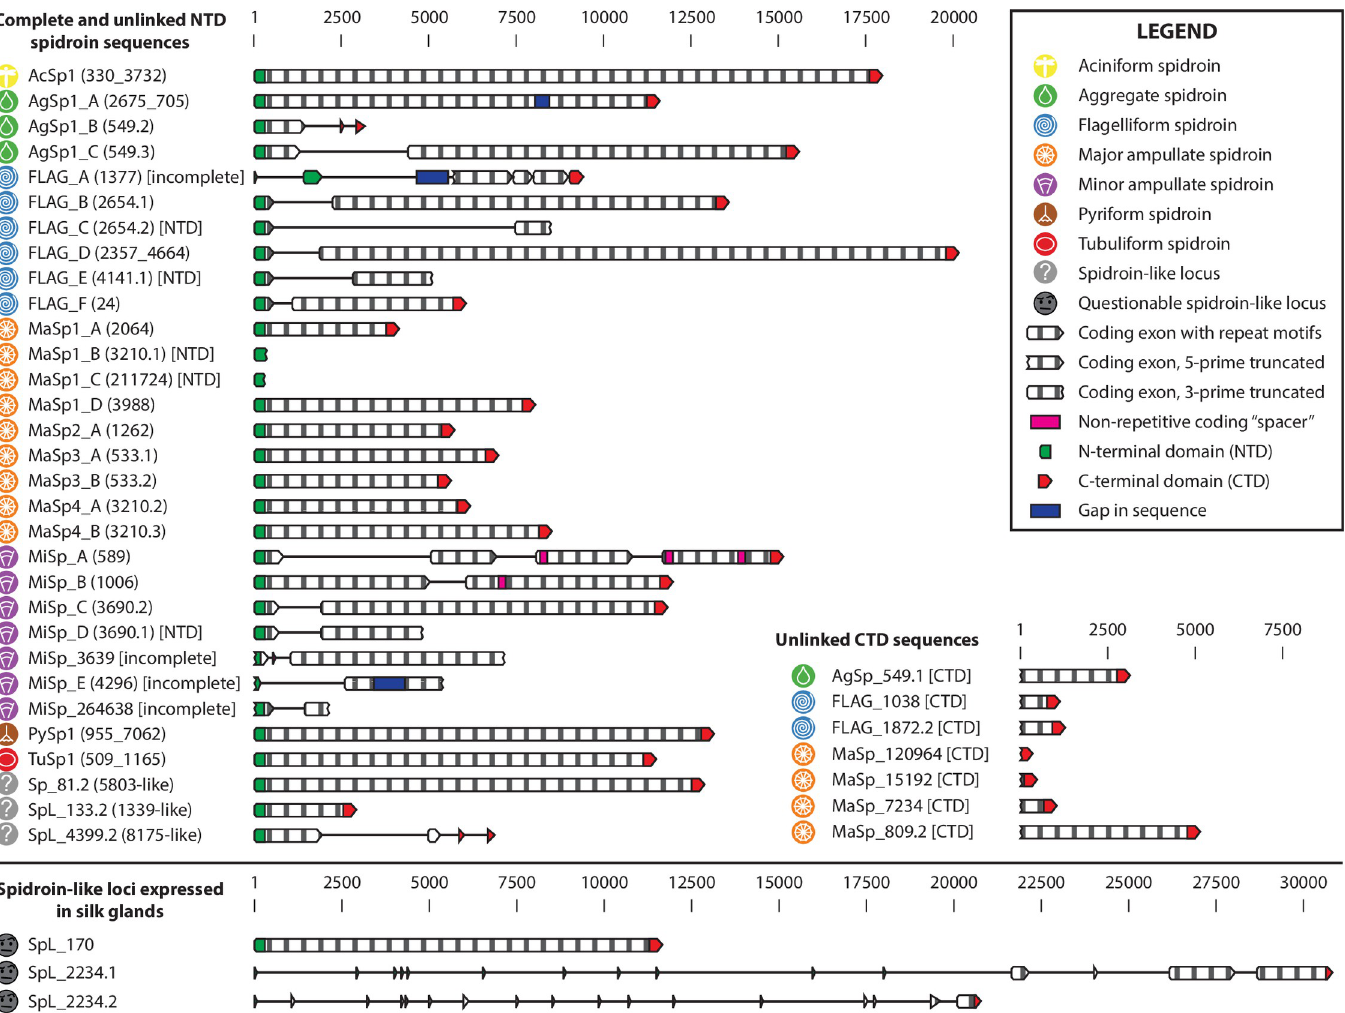
Fig 1. A catalog of spidroin genes identified in Caerostris darwini . Circular symbols denote the silk class of each spidroin, determined by alignment of N and C-terminal domains and motifs to previously known spidroin sequences. Genic structures are drawn to scale. Scaffold identifiers for the locations of the genes are provided in parentheticals, or embedded in the name (for Spidroin-like sequences). AcSp: Aciniform, AgSp: aggregate; FLAG: flagelliform; MaSp: major ampullate; MiSp: minor ampullate; PySp: pyriform; TuSp: Tubuliform; SpL: